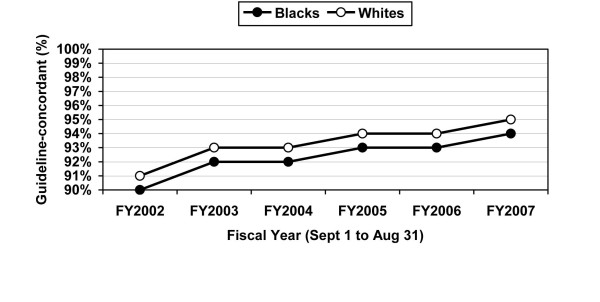
Annual guideline-concordant prescribing for African-American and Caucasian VHA patients with CAP managed in the medical wards (non-ICU patients)*. *The numbers in the figure represent the crude (unadjusted) guideline-concordant antibiotic prescribing rates.